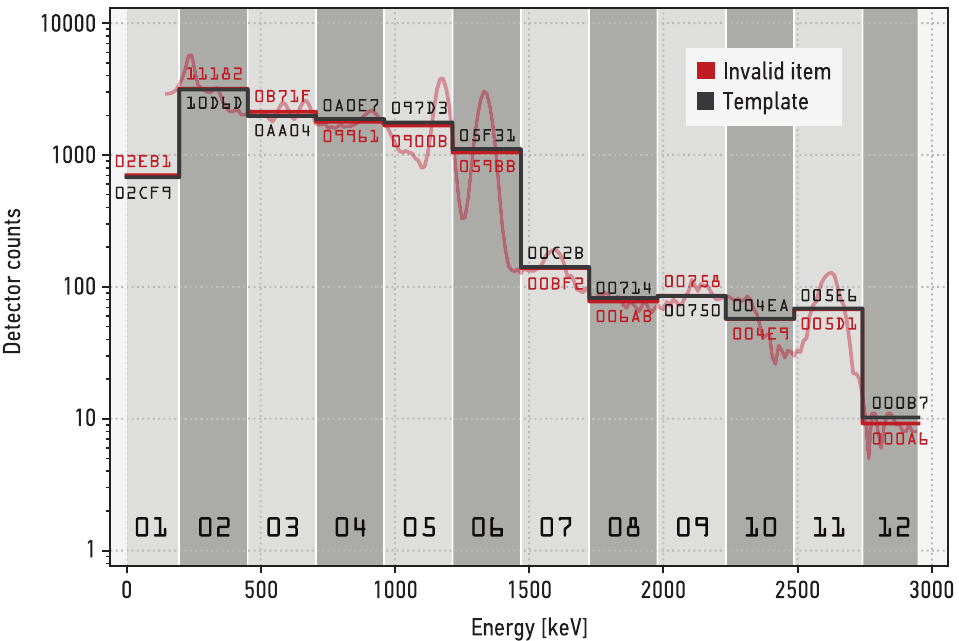
Fig 5. Count rates in IBX II broad-energy bins. The template values (gray line) are used for the χ 2 test in all future inspections. For reference purposes, the spectrum and the corresponding bin values from a single measurement of an invalid item (cobalt-60 source with a weak caesium-137 contribution) are shown (red line). Bin values for the invalid item and the template are in hexadecimal format.